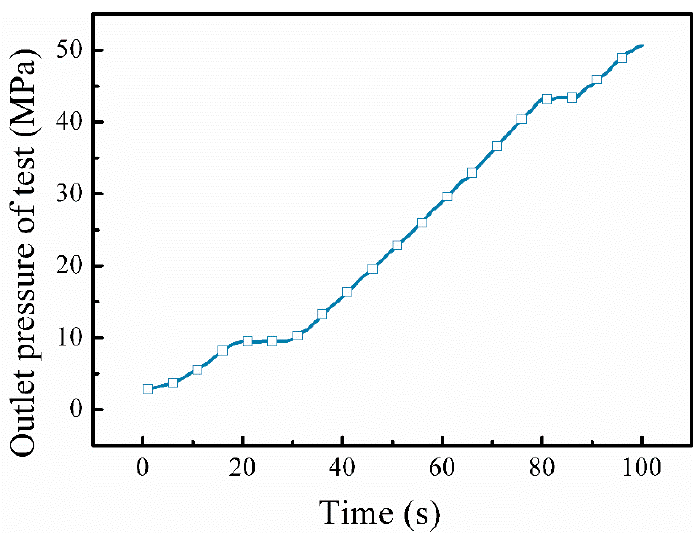
Figure 16. Test pressure curve of liquid hydrogen pump boosted to 50.6 Mpa.